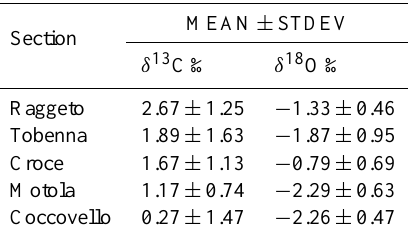
Table 4. Mean and Standard deviation for carbon and oxygen iso- tope ratios of the studied sections MEAN ± STDEV Section δ 13 C‰ δ 18 O‰ Raggeto 2.67 ± 1.25 − 1.33 ± 0.46 Tobenna 1.89 ± 1.63 − 1.87 ± 0.95 Croce 1.67 ± 1.13 − 0.79 ± 0.69 Motola 1.17 ± 0.74 − 2.29 ± 0.63 Coccovello 0.27 ± 1.47 − 2.26 ±